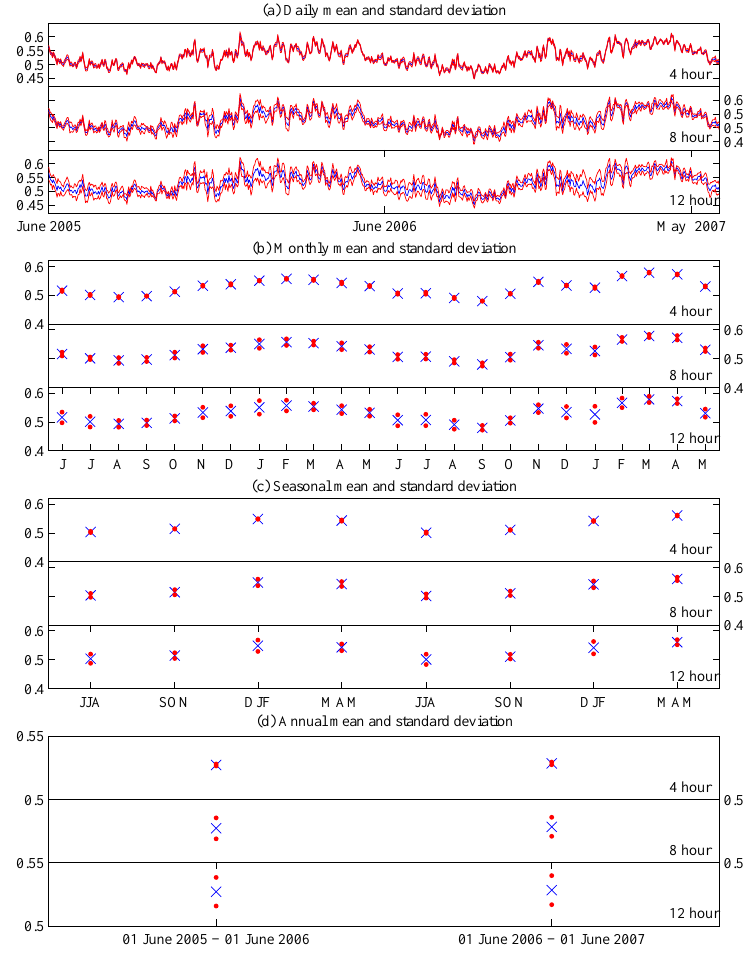
Figure 3. The blue curves/points show t for the sunlit land ( a ) daily; ( b ) monthly; ( c ) seasonal; and ( d ) annual intervals. The red curves/points show t ± σ r , n . Within each panel, the three sub-panels show, from top to bottom, 4-, 8-, and 12-h sampling frequency. Vertical scale is fixed within each set of three